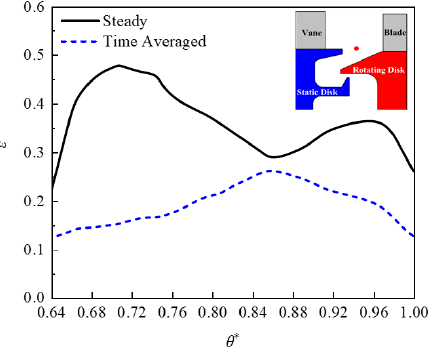
Figure 12. Circumferential distribution of sealing effectiveness at the sealing outlet (Seal-A and IF = 0.6%). IF =